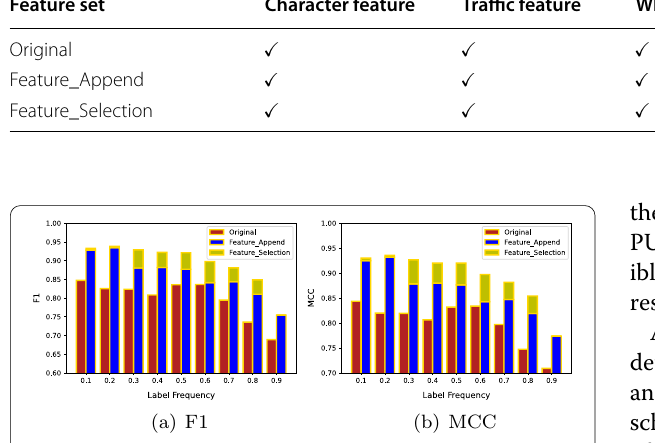
Fig. 7 Feature set evaluation performance histogram. ( a ) Prediction F1 changes. ( b ) Prediction MCC changes